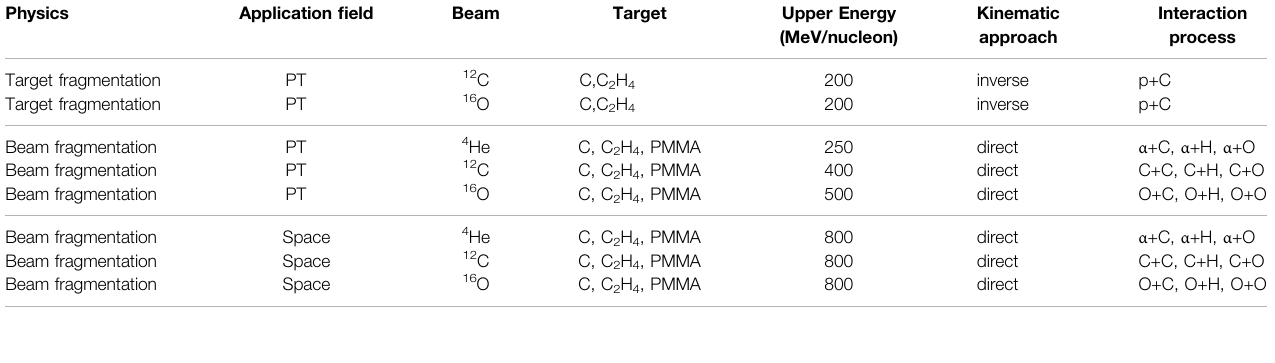
TABLE 1 | FOOT physics program: in the last column the interaction processes to be studied for a given combination of beam, target, energy and kinematic approach are shown. Physics